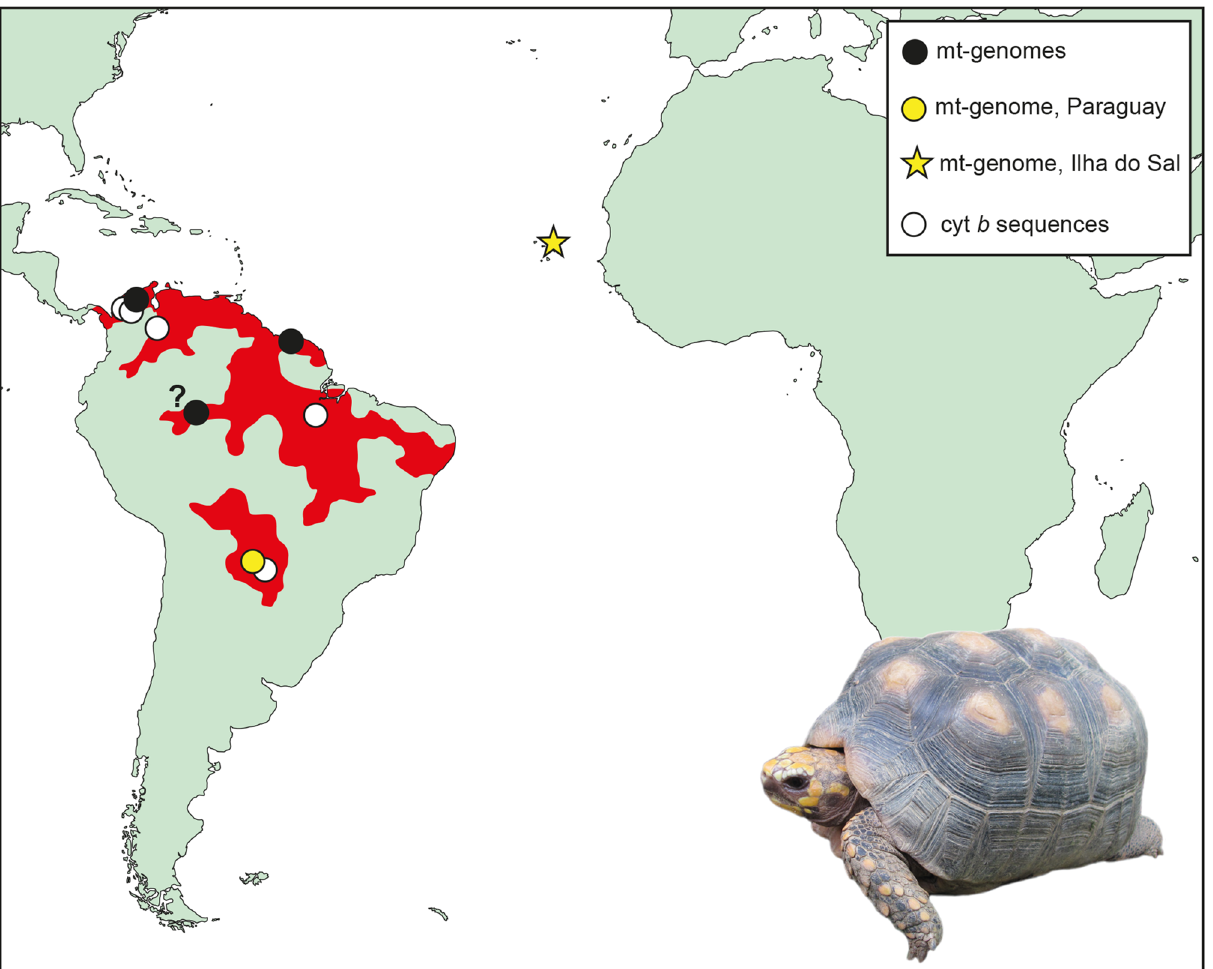
Figure 1. Location of Sal Island (Ilha do Sal), putative collection site of the type material of Geochelone atlantica López-Jurado, Mateo and García-Márquez, 1998, distribution range of Chelonoidis carbonarius 11 (red), and collection sites of genetically studied material. The question mark denotes the uncertain collection site of a museum specimen of 1831 (see text). The map was created using ArcGIS 10.4 (https:// www. esri. com/ en- us/ arcgis/ about- arcgis/ overv iew) and Adobe Illustrator CS6 (http:// www. adobe. com/ produ cts/ illus trator. html). Inset photo (J. P. Hurtado Gómez): Chelonoidis carbonarius